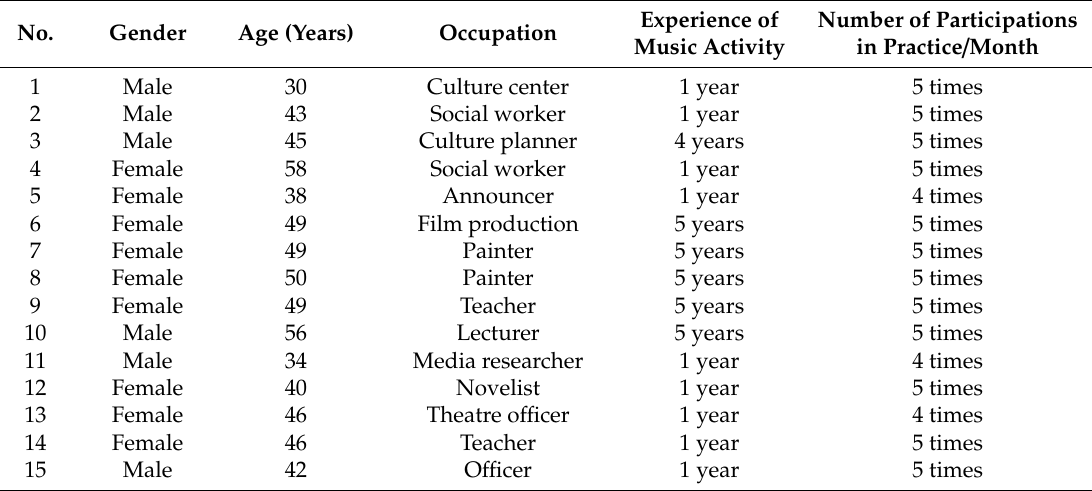
Table 1. Participant characteristics.